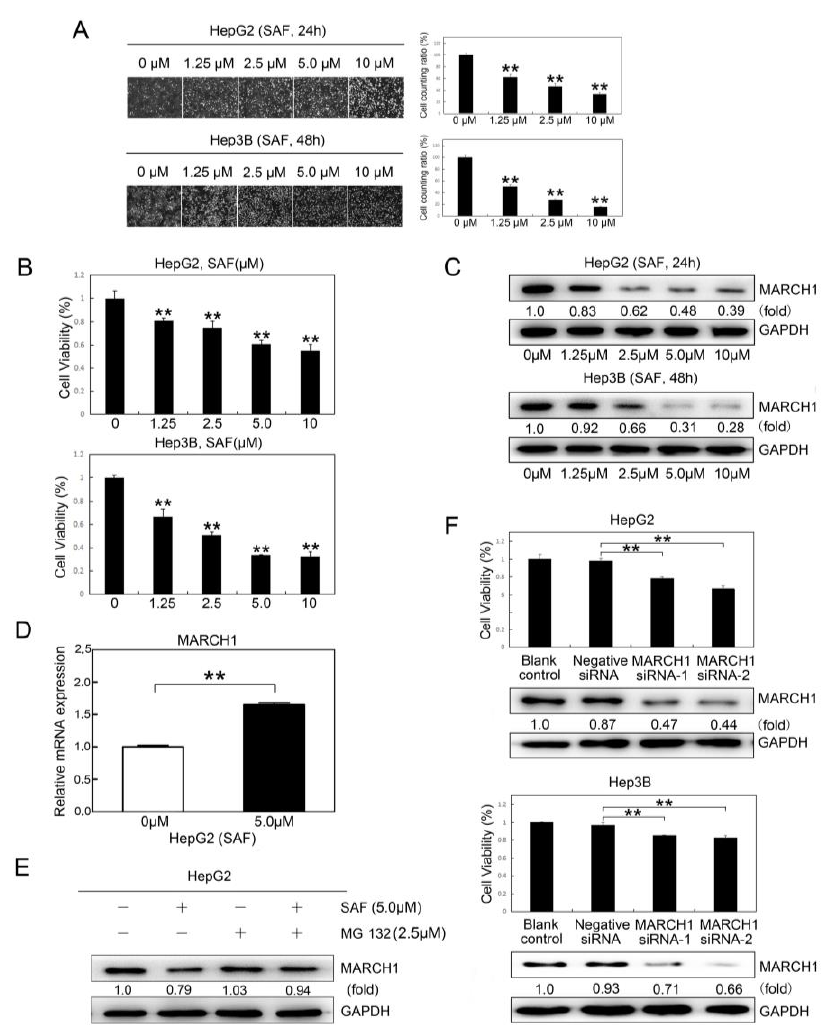
Figure 1. Effect of SAF on HCC cell proliferation. ( A ) Representative images of human HepG2 and Hep3B HCC cells treated with 0, 1.25, 2.5, 5.0, and 10 μM SAF for 24 h and 48 h, respectively. ( B ) Cell